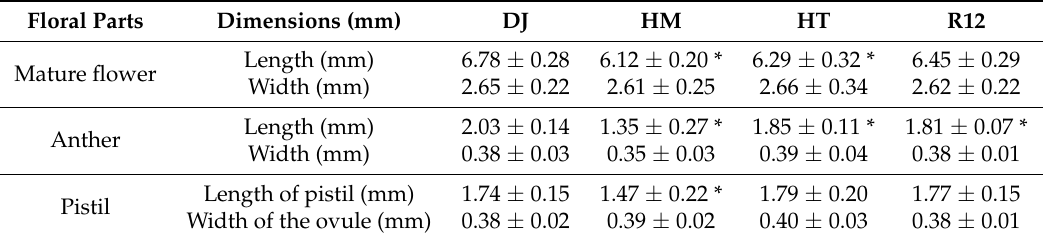
Table 1. Morphological comparison of flowers, pistil, and stamen parts of the wild type (DJ), HM, HT, and complemented line